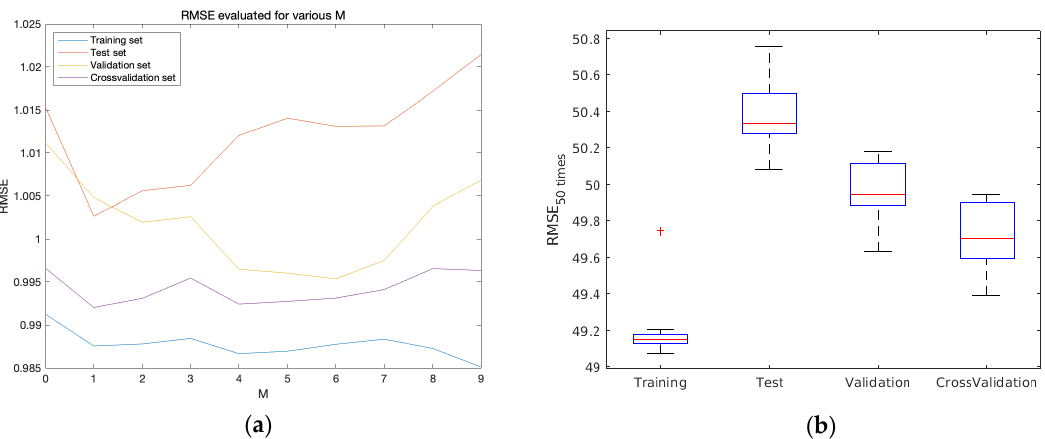
Figure 5. ( a ): Graphs of RMSE of each order in 600 training, 200 test, 200 validation and cross validation dataset. Cross validation performs with 800 training(training + validation) dataset and 200 test dataset. ( b ): Boxplot of total sum of RMSE on the dataset.